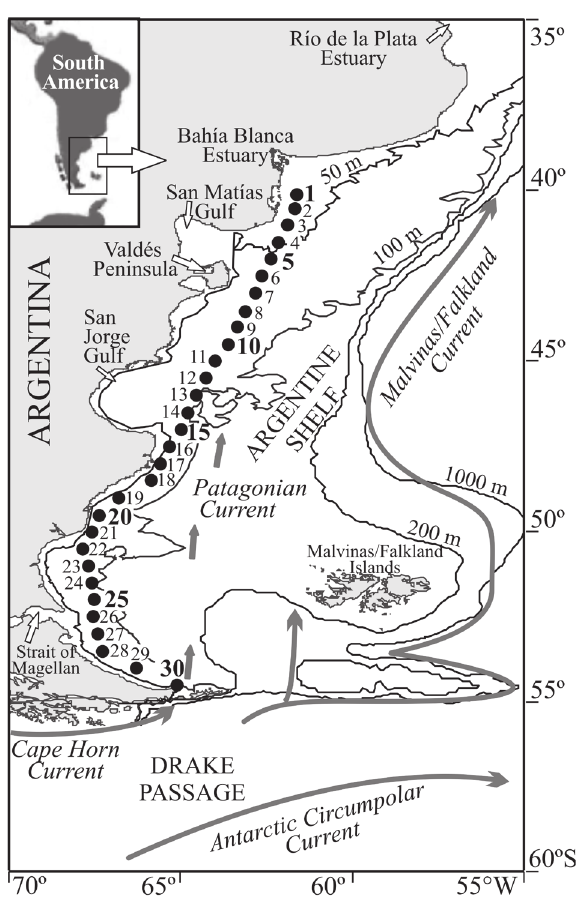
Fig . 1. – area studied. arrows and circles indicate general circula- tion of the main currents and the location of oceanographic stations, respectively . Fig . 2. – Morphological features examined on the lorica of Helicos- tomella specimens. Bar = 20